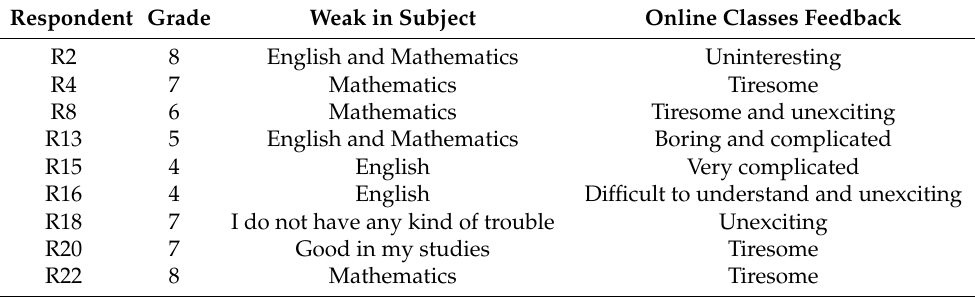
Table 4. LBC academic adjustment during